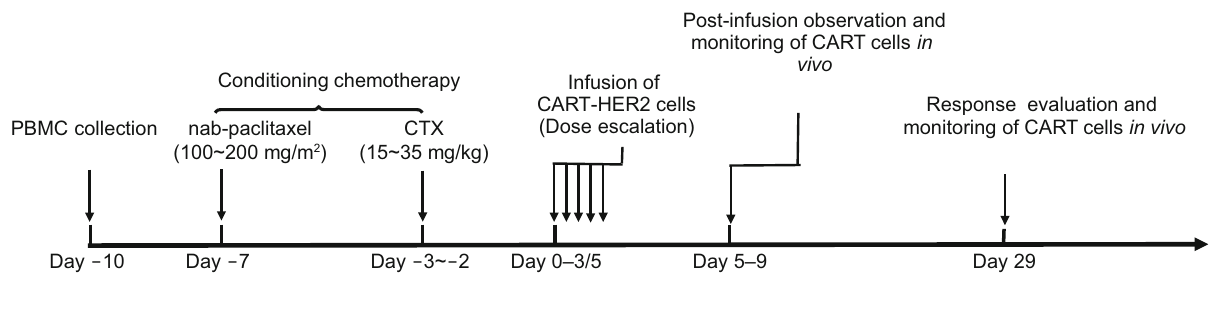
Figure 5. Study fl owchart of CART-HER2 therapy. PBMC: peripheral blood mononuclear cell.